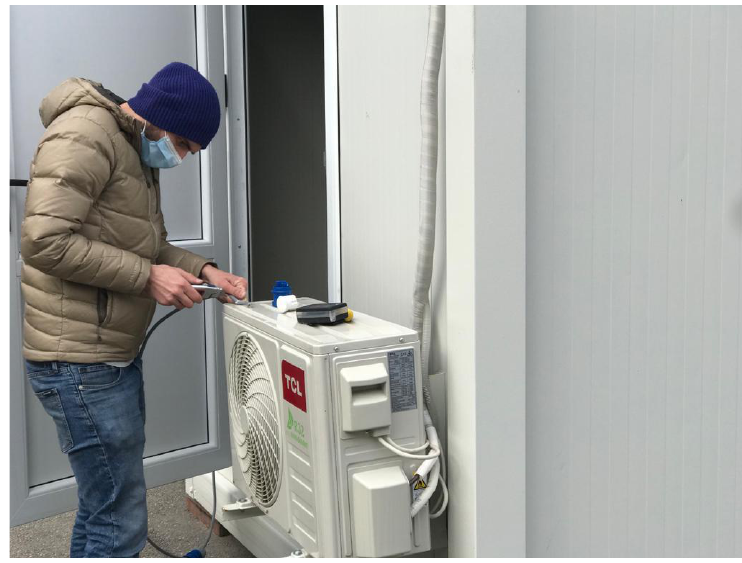
Figure 9. Air conditioner.